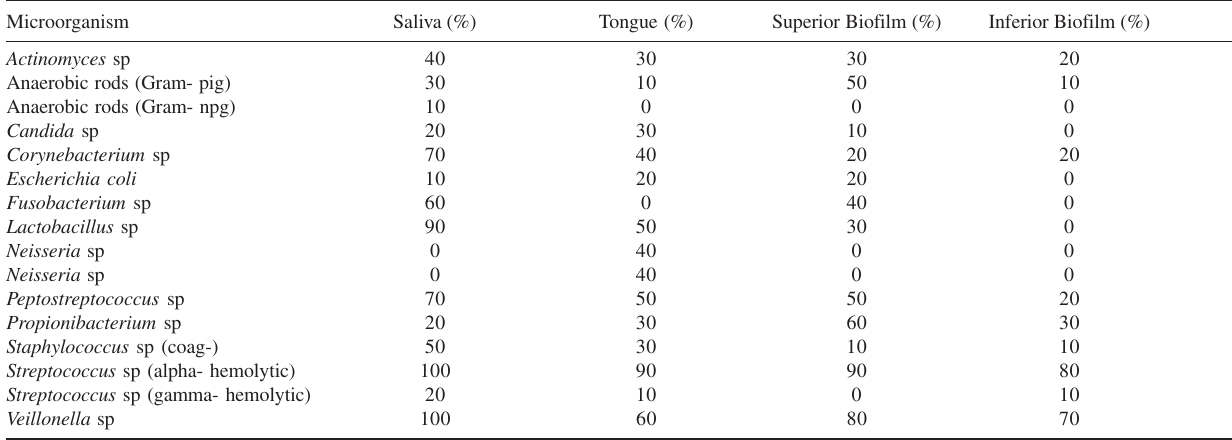
Table 1 - Frequency and locations of microorganisms in the oral cavity Microorganism Saliva (%) Tongue (%)